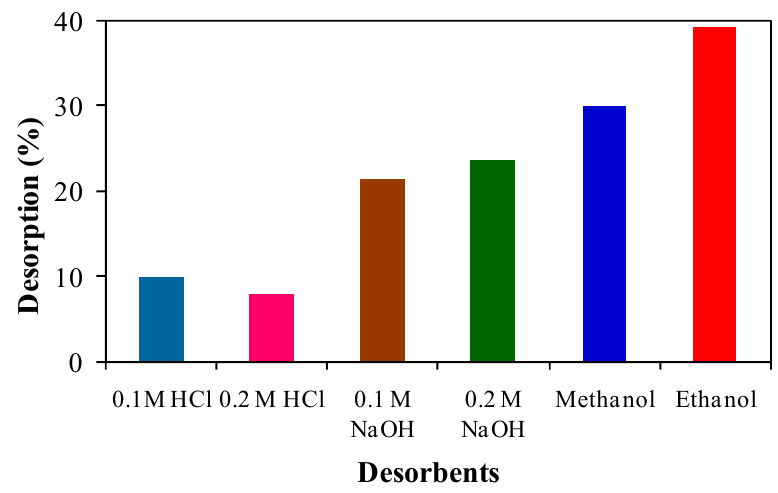
Figure 6. Desorption of RBV-5R from SCB using different reagents.